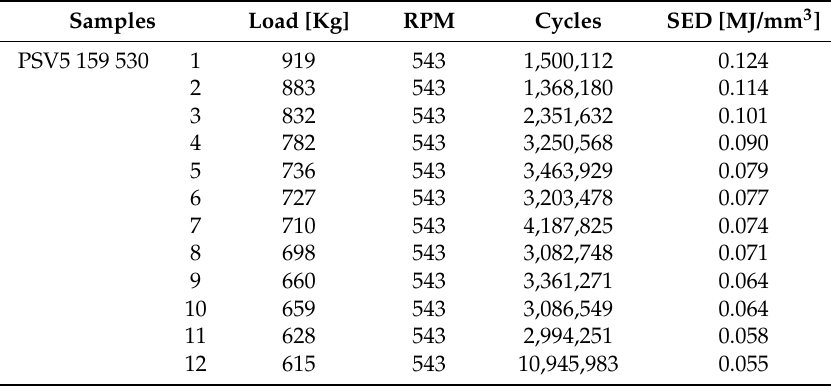
Table 8. Fatigue data for the roller PSV5 159 530.